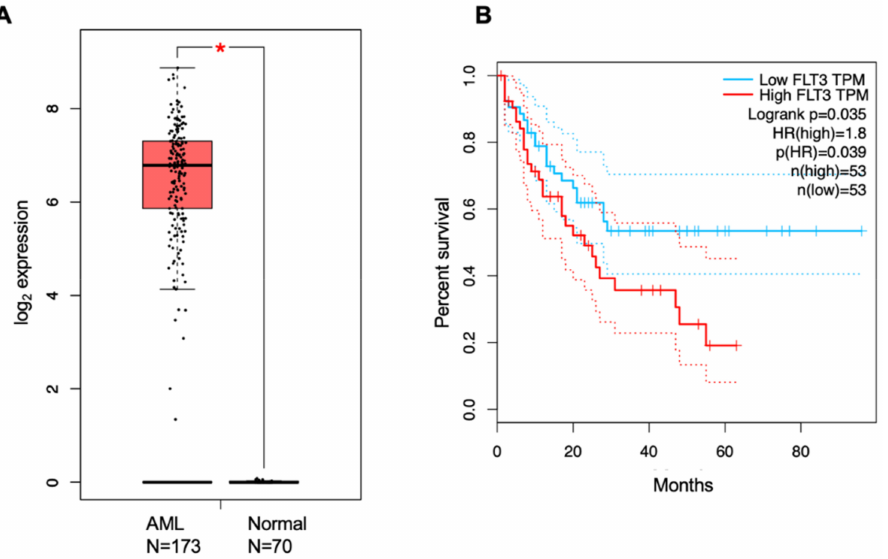
Figure 2. Analysis of FLT3 expression in AML patients. ( A ) Transcript levels of FLT3 in AML patients versus control patients. ( B ) Percent survival of high-FLT3-expressing patients versus low-FLT3- expressing AML patients. The hazard ratio is 1.8, and the p -value is 0.035, as analyzed from the TCGA dataset upon GEPIA